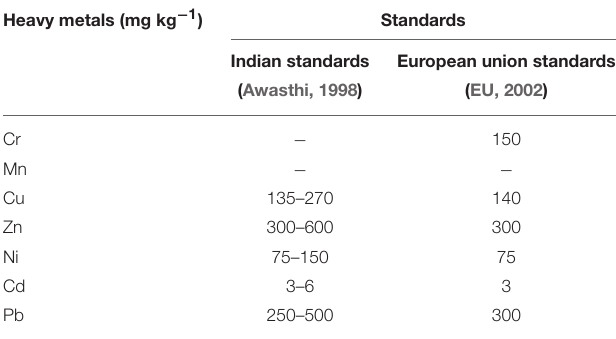
TABLE 3 | Permissible limit of heavy metals in agricultural